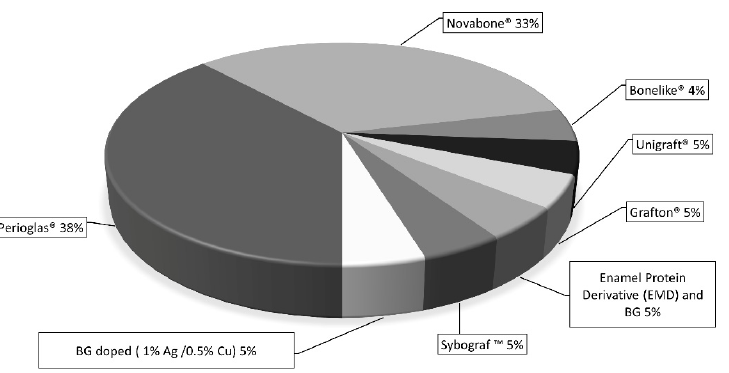
Figure 4. Different types of BGs used in clinical studies in periodontal patients from 2006 to 2021. The flow diagram of the included articles is illustrated in Figure 5.